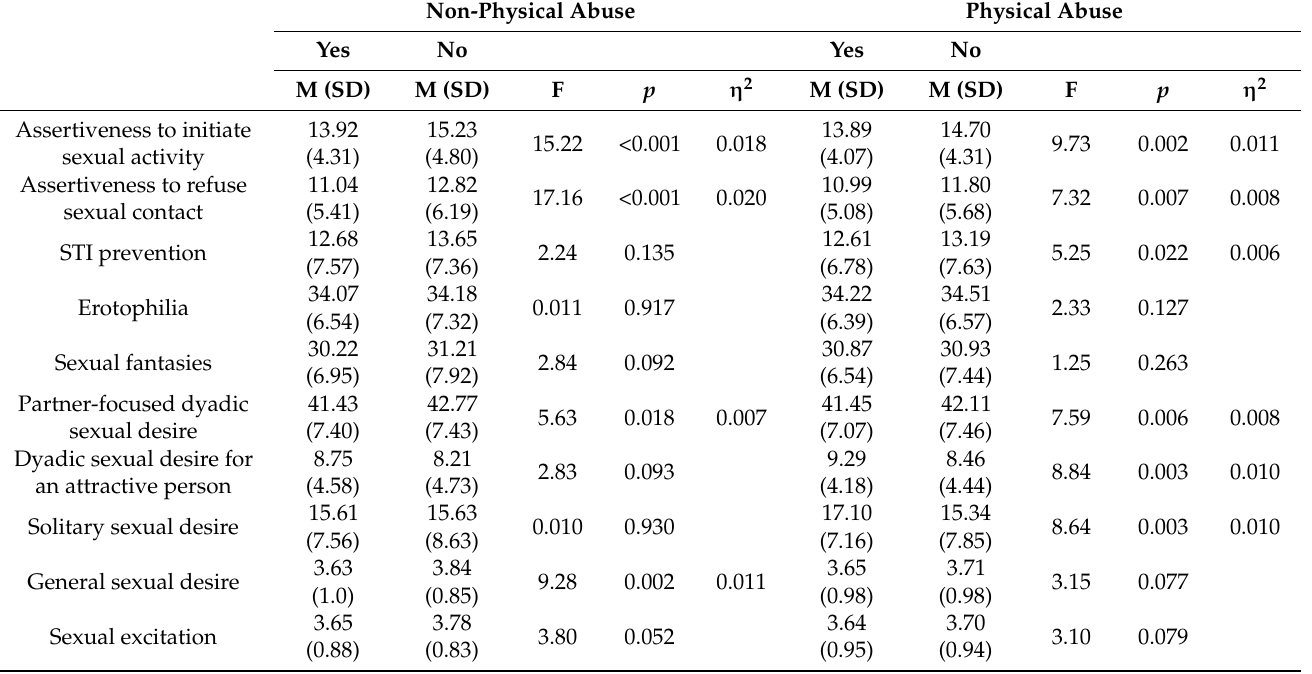
Table 2. Differences of each type of abuse on the sexual health variables controlling covariates in